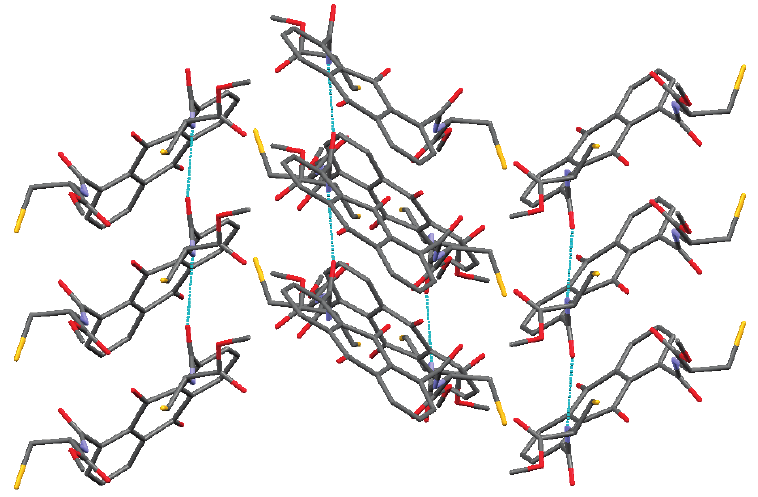
Figure 3. Packing diagram of the unit cell along the c axis. Hydrogen atoms are omitted for clarity. Intermolecular hydrogen bondings are indicated by dotted blue